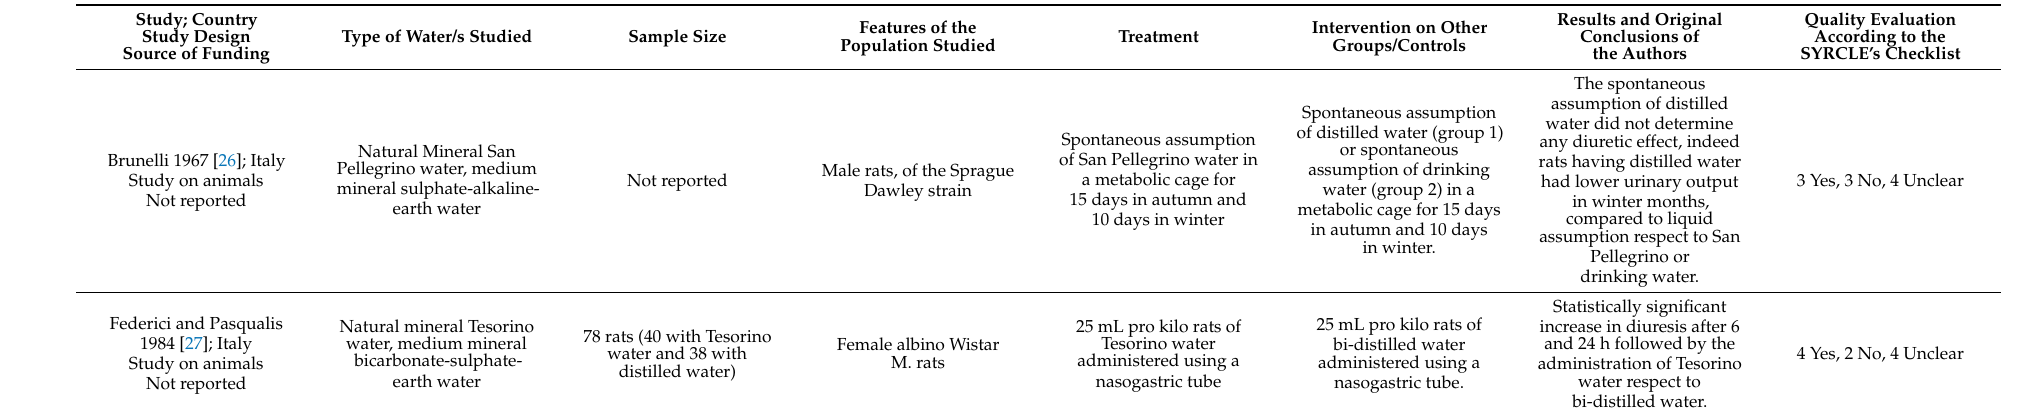
Table 2. Features of animals’ studies included in the systematic